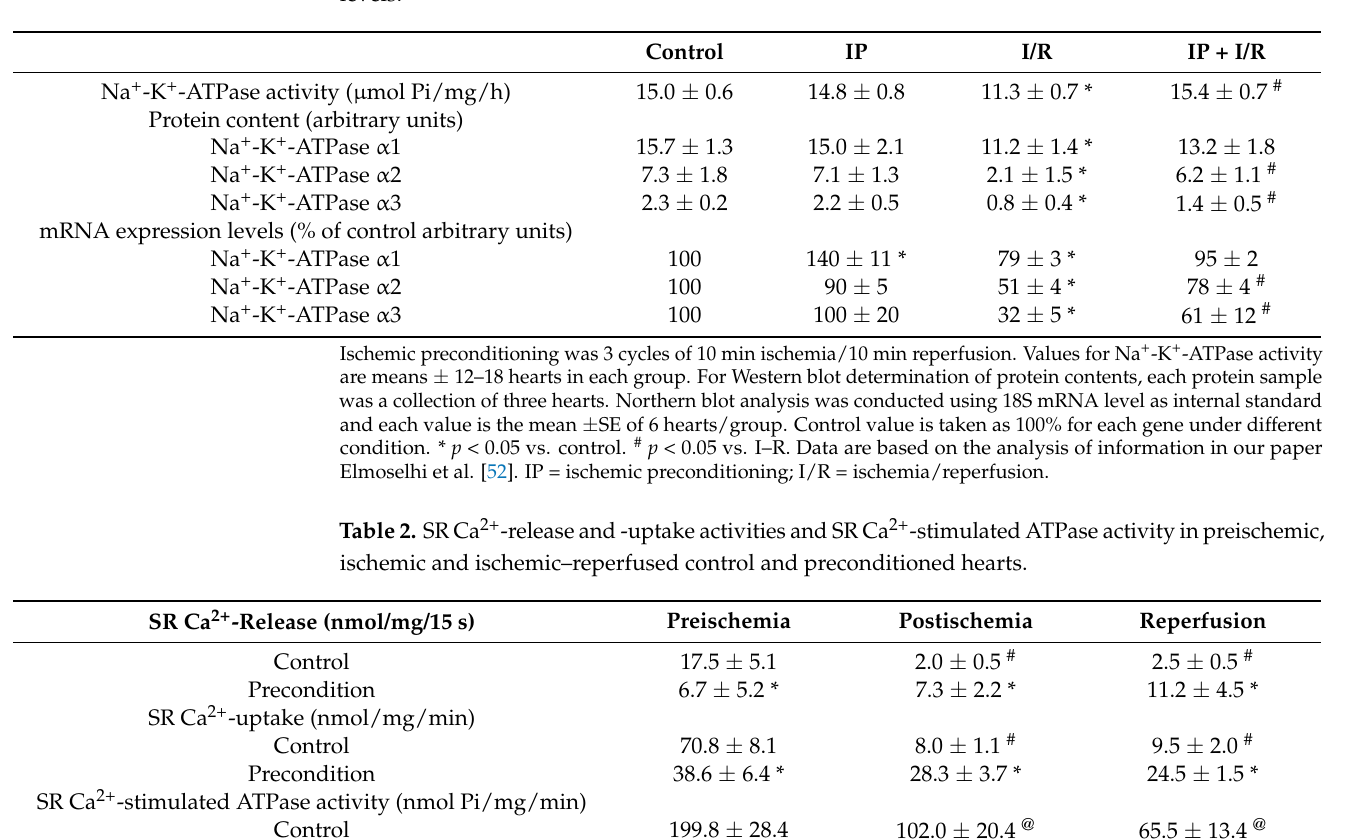
Table 1. Effect of ischemic preconditioning on Na + -K + -ATPase activities, protein contents and mRNA levels.